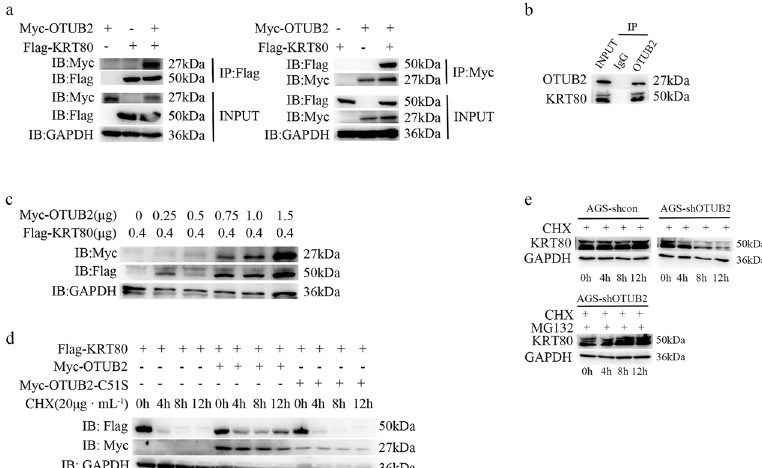
Fig. 4 OTUB2 interacts with and stabilizes KRT80. a Reciprocal co-IP of OTUB2 and KRT80. Plasmids encoding Myc-tagged OTUB2 and Flag- tagged KRT80 were co-transfected into HEK293T cells. Cell lysates were immunoprecipitated with anti-Flag or anti-Myc antibodies, followed by western blotting as indicated. b Endogenous co-IP of OTUB2 and KRT80 in AGS cells. Anti-OTUB2 and anti-KRT80 antibodies were used to immunoprecipitate cell lysates, which were then identi fi ed by western blotting. c Flag-tagged KRT80 (0.4 μ g) was co-transfected into HEK293T cells with the speci fi ed doses of Myc-OTUB2 (0.25, 0.5, 0.75, 1, and 1.5 μ g) and Myc vector. After 48 h, the transfected cells were harvested and western blotting analysis was performed. d Effects of OTUB2 on the degradation of KRT80 in HEK293T cells. Flag-tagged KRT80 was co-transfected into HEK293T cells with or without Myc-tagged OTUB2 or OTUB2-C51S and treated with CHX at various time points (0, 4, 8, and 12 h) prior to harvesting. The amount of Flag-tagged KRT80 protein was determined using an anti-Flag antibody. e Effects of OTUB2 on the degradation of KRT80 in gastric cancer cells. AGS-shck/shOTUB2 cells were exposed to CHX (20 μ g/mL) and harvested at the indicated times. KRT80 was measured using western blotting. KRT80 was stabilized when cells were co-treated with CHX and MG132 (20 μ M).